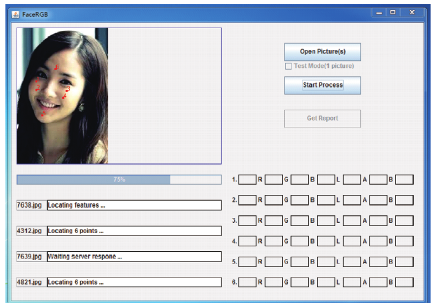
Figure 8: Processing with four computation channels.